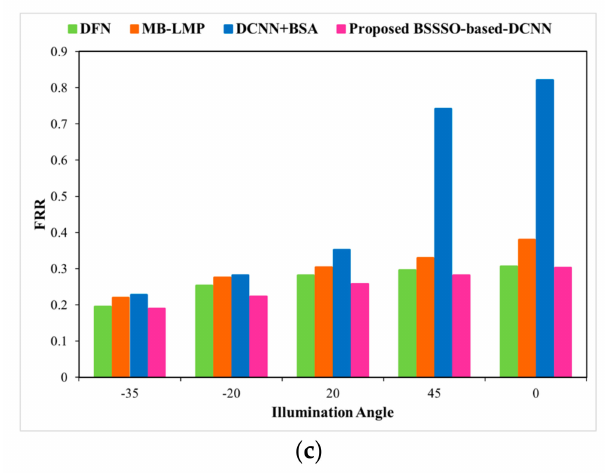
Figure 11. Analysis using Extended Yale B database by illumination angle.